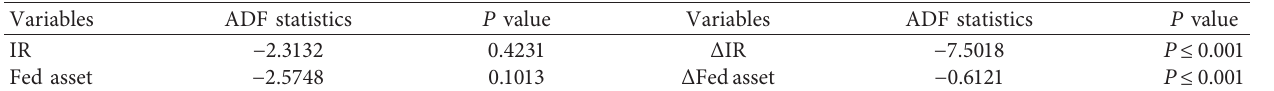
Table 3: The results of ADF test.